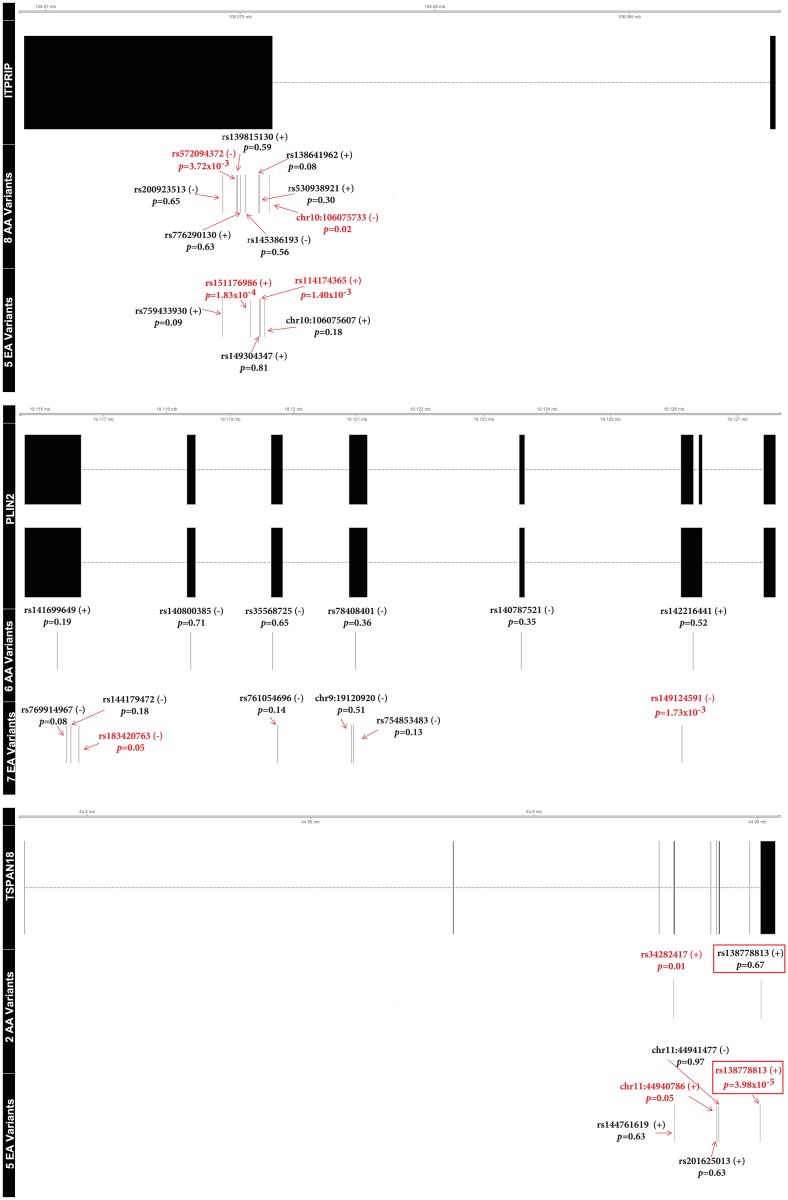
Variants contributing to the significant T5 gene-based tests.This figure depicts the single-variant model results for variants contributing to the T5 tests of ITPRIP, PLIN2, and TSPAN18 on the third visit aβ42: aβ40 ratio. One isoform was drawn unless the regions harboring variants differed substantially. Each contributing variant is labeled by name, single-variant association p-value, and direction of the minor allele effect (in parentheses). Variants with nominal (p<0.05) levels of association are in red. Overlapping variants in the two racial groups are encapsulated by a red box.